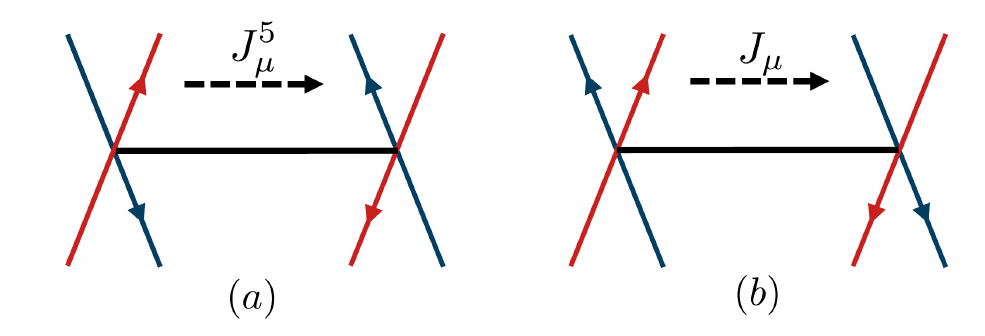
Figure 14: Radial view of the annulus geometry (black line) with energy spectra of right-moving (red) and left-moving (blue) edge modes in the quantum spin Hall effect. The arrows show the spectral flow under adiabatic changes of: ( a ) the A field; ( b ) the A field. The compensating bulk currents are 5